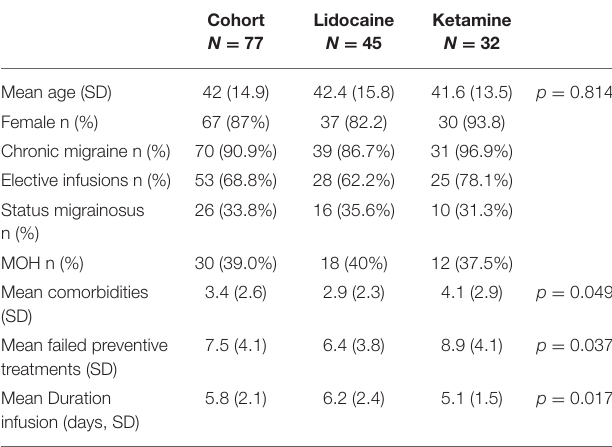
TABLE 3 | Characteristics of migraine